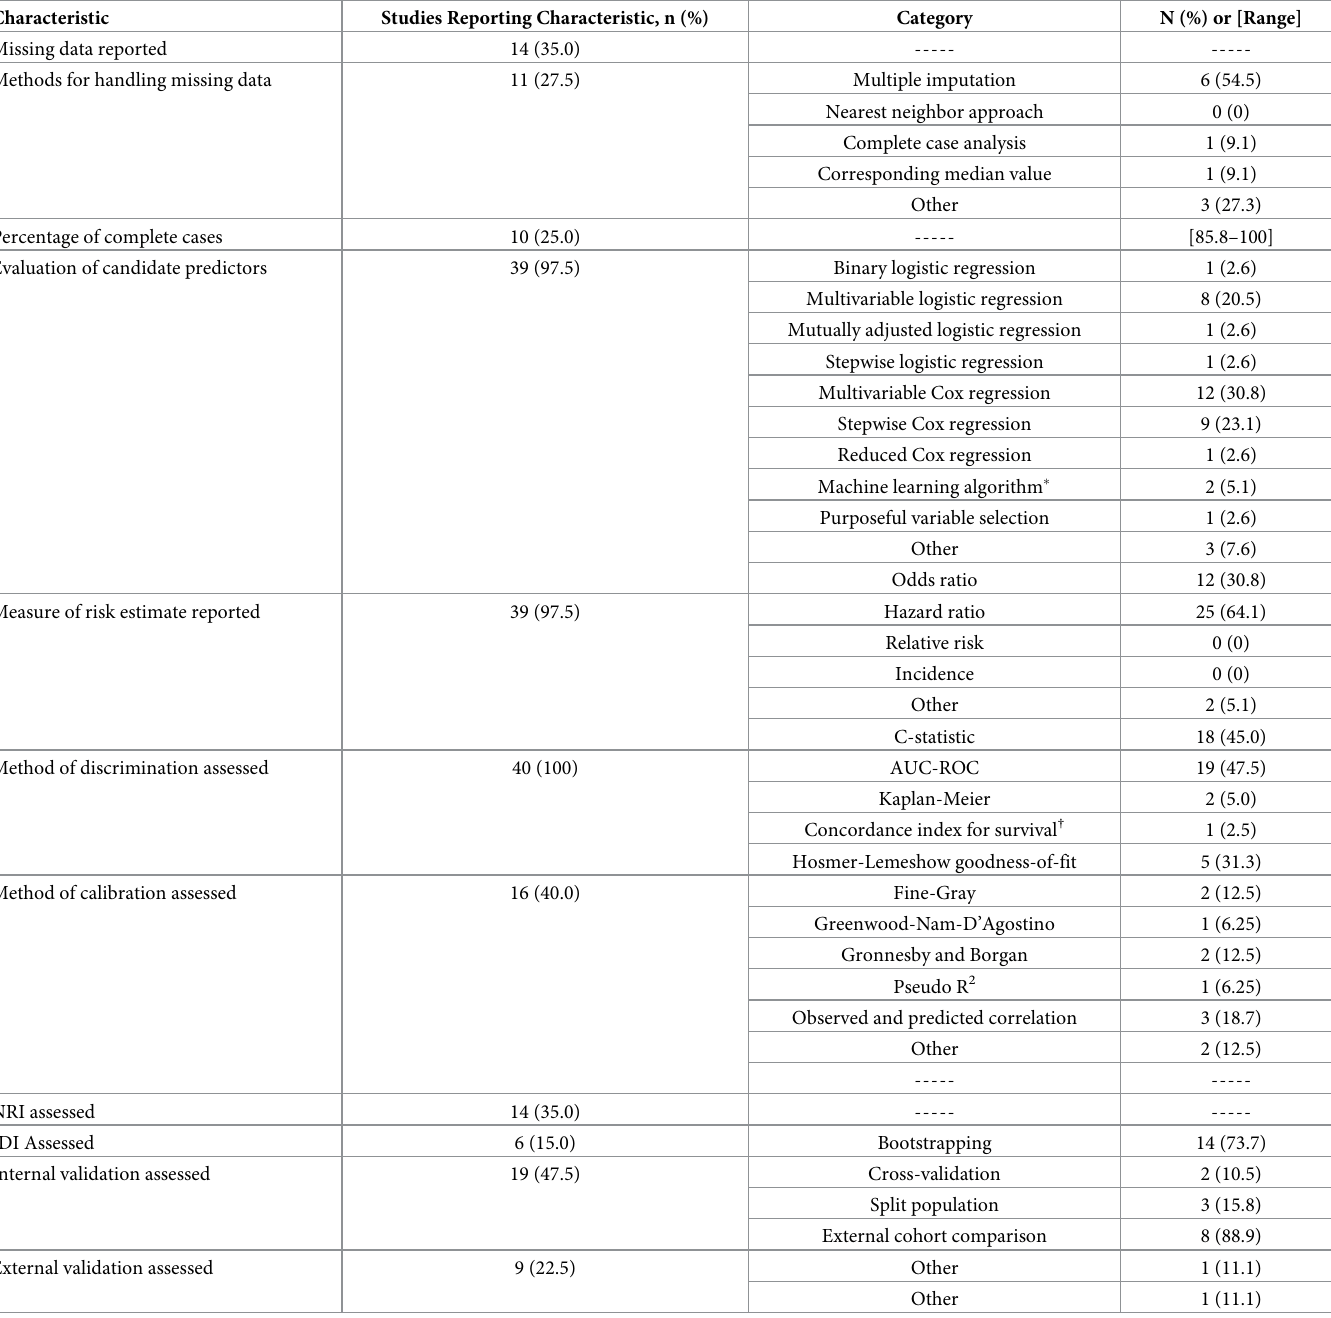
Table 2. Methods reported for model development and validation in the 40 retrieved publications on models of HF risk prediction.